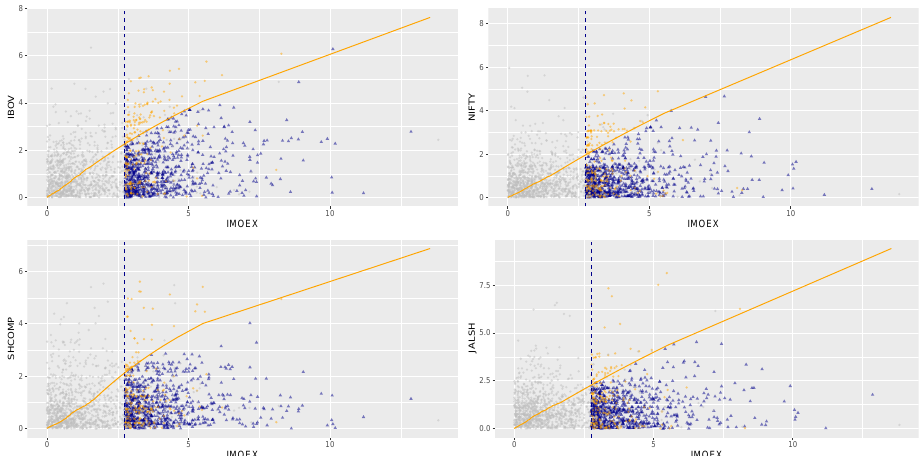
Figure 8. Prediction plot conditioning on IMOEX being above its 90th percentile.